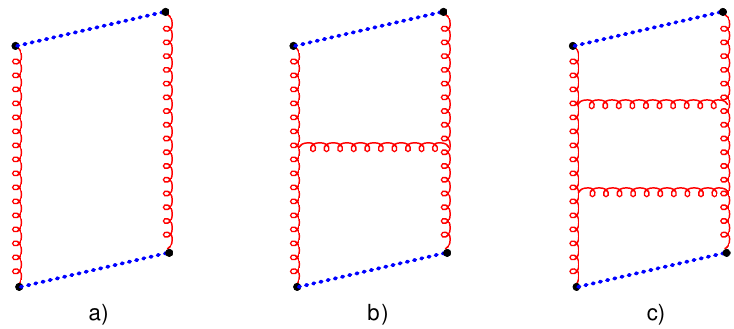
Figure 13 . First three order diagrams for the correlator of two “quasi-PDF” frames. Diagrams a) and b) are not included in the product of two dipole Wilson-line